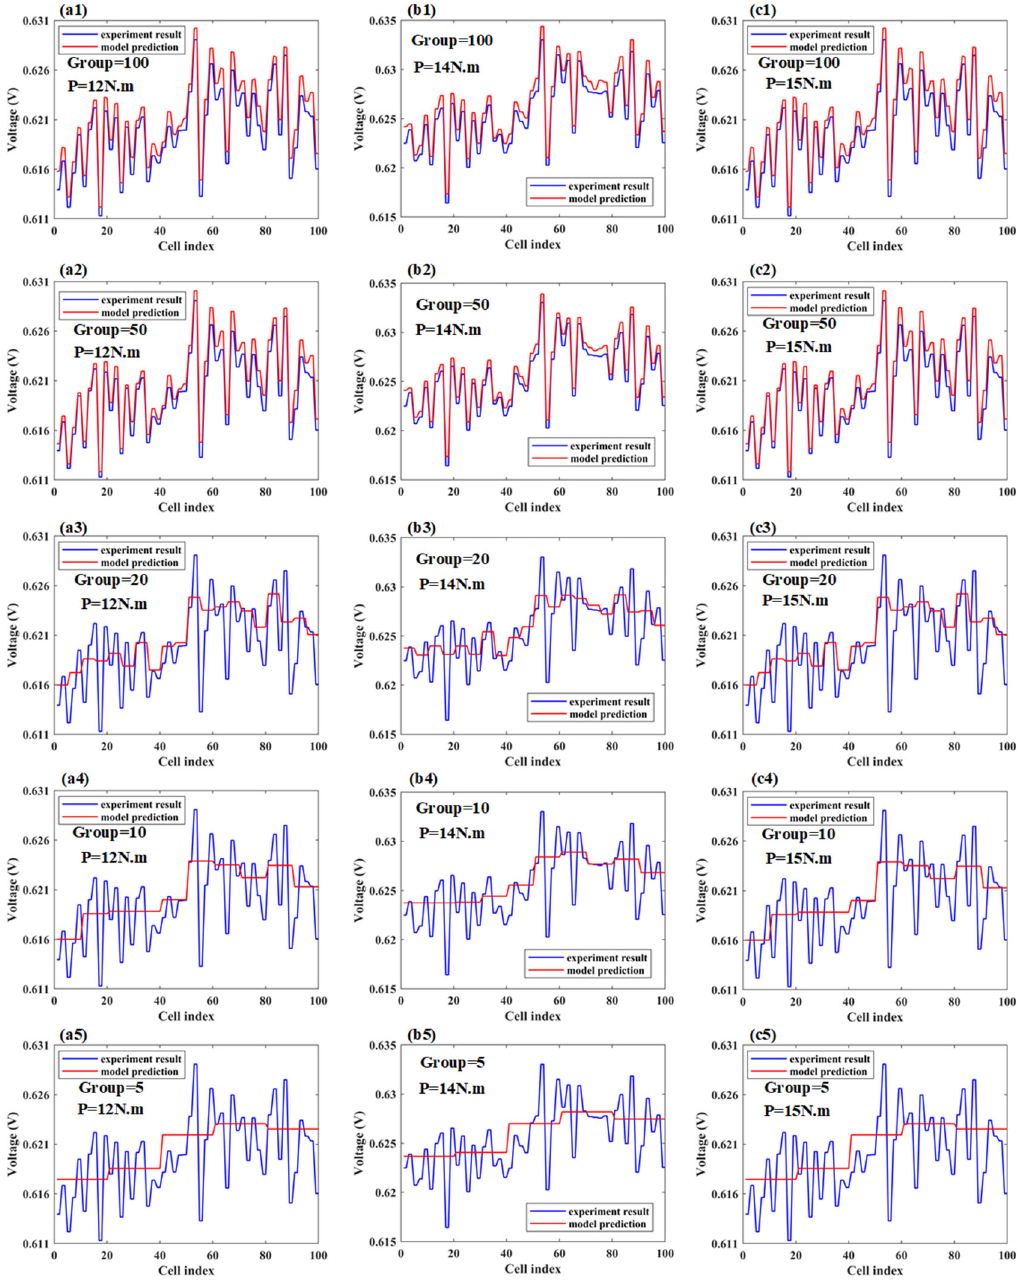
Figure 6. Comparison between the model and experiment results of cell voltage distributions under the load current density of 1.5 A/cm 2 with different assembly torques: ( a1 , a2 , a3 , a4 , a5 ) 12 N.m; ( b1 , b2 , b3 , b4 , b5 ) 14 N.m; ( c1 , c2 , c3 , c4 , c5 ) 15 N.m.